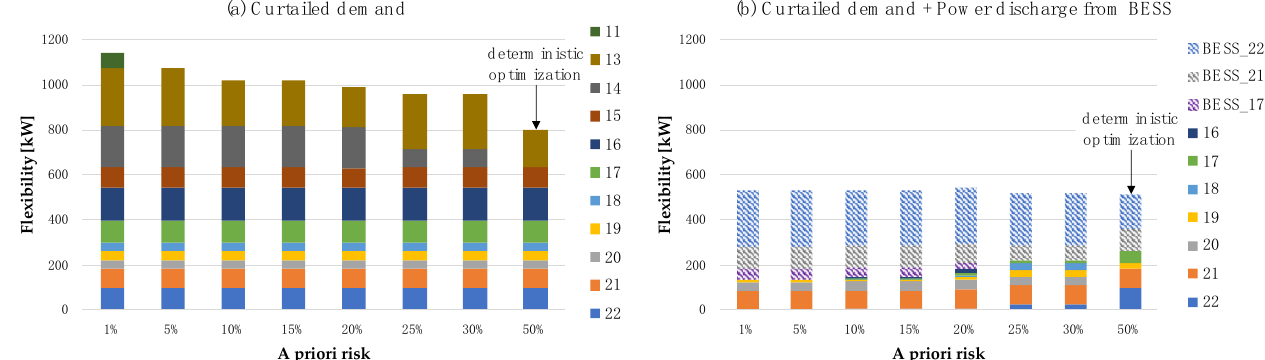
Figure 9. Comparison of flexibility exploitation (differentiated by resources with different colours) by varying the a priori risk: ( a ) deterministic and robust optimization without storage; ( b ) deterministic and robust optimization with storage. Table 5. Detailed results of the four core-settings for the single hour contingency (19th). The values of Γ are calculated for the technical constraints of feeder F2 (|J n | = 15) .